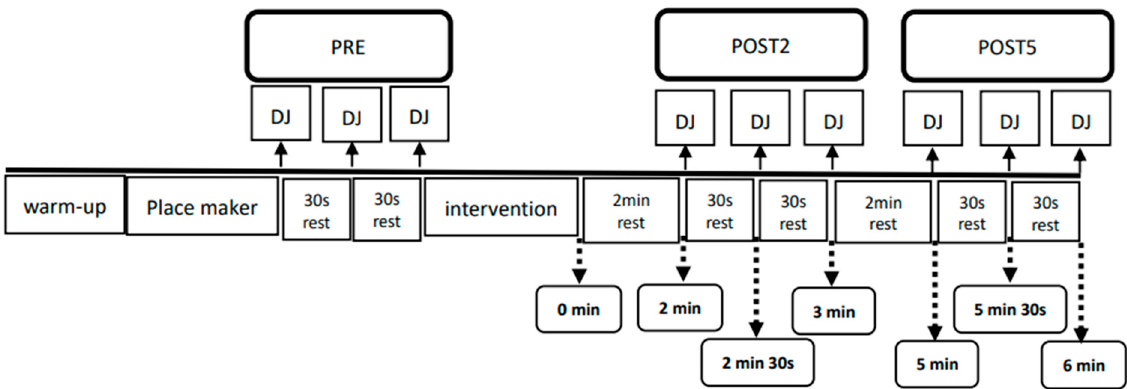
Figure 1. Schematic diagram of the experimental